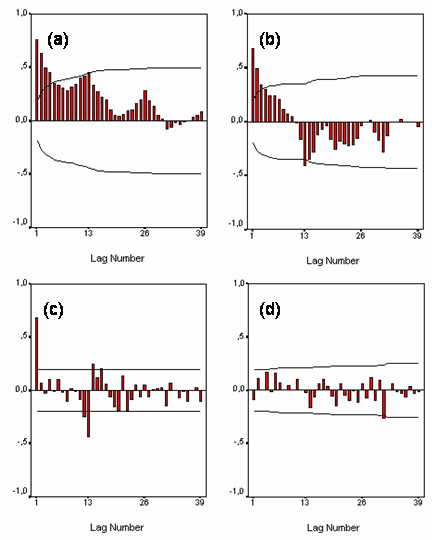
Pertussis (1953–1962): (a) autocorrelation function (ACF) of ln xt; (b) autocorrelation function (ACF) of ∇13 ln xt; (c) partial autocorrelation function (PACF) of ∇13 ln xt; (d) autocorrelation function of the residuals.